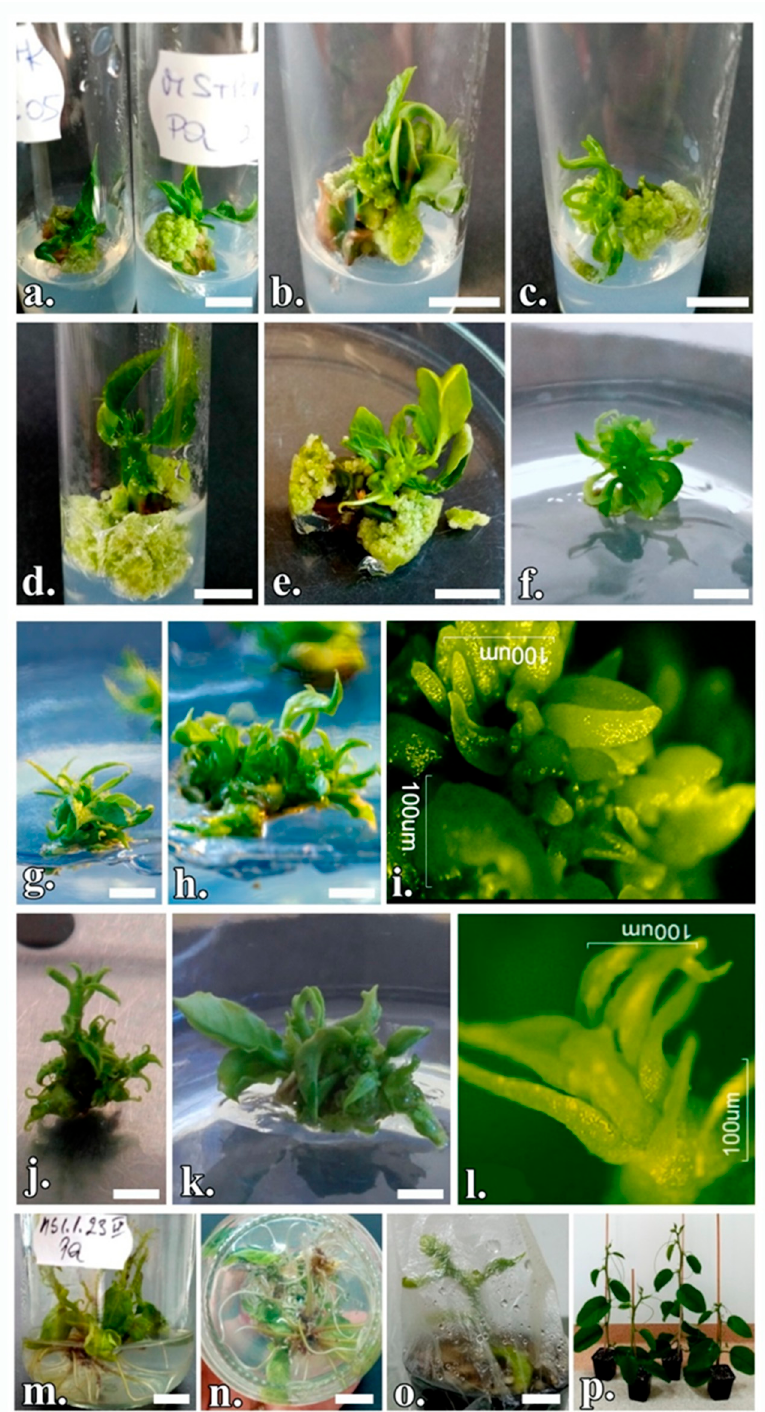
Figure 3. Regenerative process from nodal segments in P. quadrangularis : ( a ) On the MS-I.4 and MS-I.8 culture medium in the absence of phenolic inhibitors; ( b ) On the MS-1 culture medium supplemented with 1 mg/L AgNO 3 ; ( c ) On MS-1 culture medium supplemented with 2 mg/L AgNO 3 ; ( d ) On MS-1 culture medium supplemented with PF-68 0.2%; ( e ) On MS-1 culture medium supplemented with PF-68 0.4%; ( f ) Microshoot on multiplication medium in the first subculture; ( g ) Microshoots cluster in the second subculture on MS-2 medium and ( h ) on MS-3 medium; ( i ) Proliferation of adventitious buds; ( j ) Cluster of microshoots in the sixth subculture on MS-2 medium and ( k ) on MS-3 medium; ( l ) de novo shoot organogenesis; ( m ) P. quadrangularis seedlings in vitro rooted; ( n ) rhizogenesis on MS-5 medium; ( o ) Acclimatization of plants; ( p ) Acclimatized plants. The scale bar represents 1 cm.